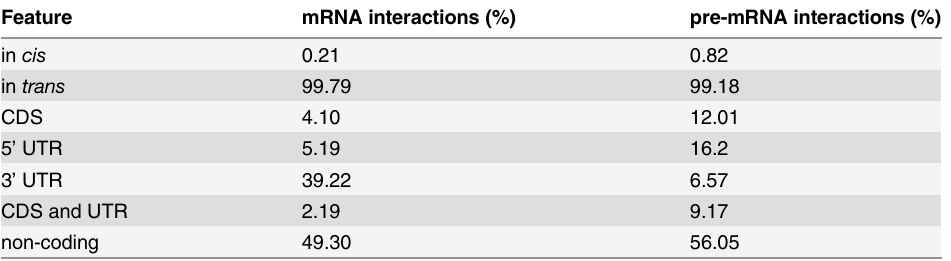
Table 1. Comparison of selected features of mRNA and pre-mRNA interactions. In cis and in trans refer to a relative position of RNA components in a genome. CDS, 5' UTR and 3' UTR denote regions in mRNAs that base-pair with